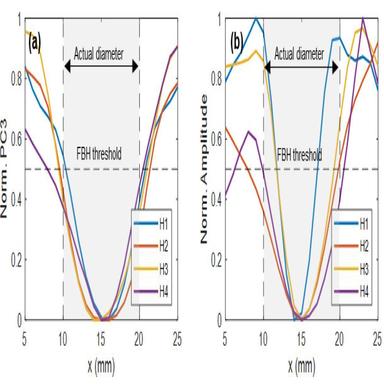
Cross section plot of FBHs by ROI centred and normalised of (a) PC3 feature and (b) SAR tomography feature.